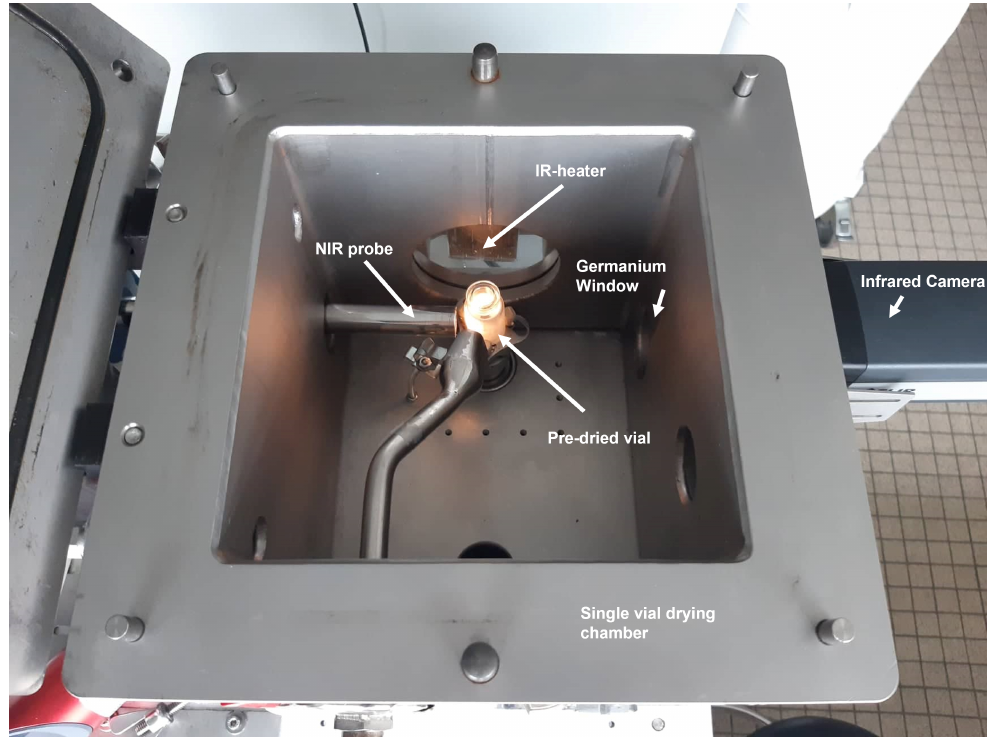
Figure 1. Single vial drying chamber and experimental setup for NIR measurements with product temperature